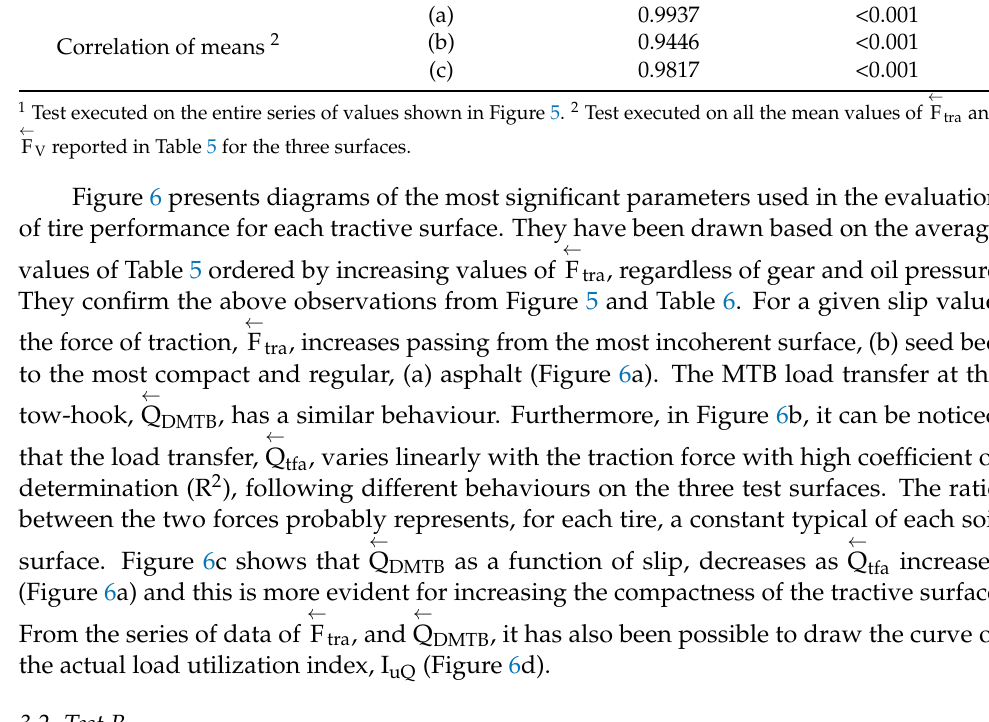
← F V . Underlined p values indicate probability of